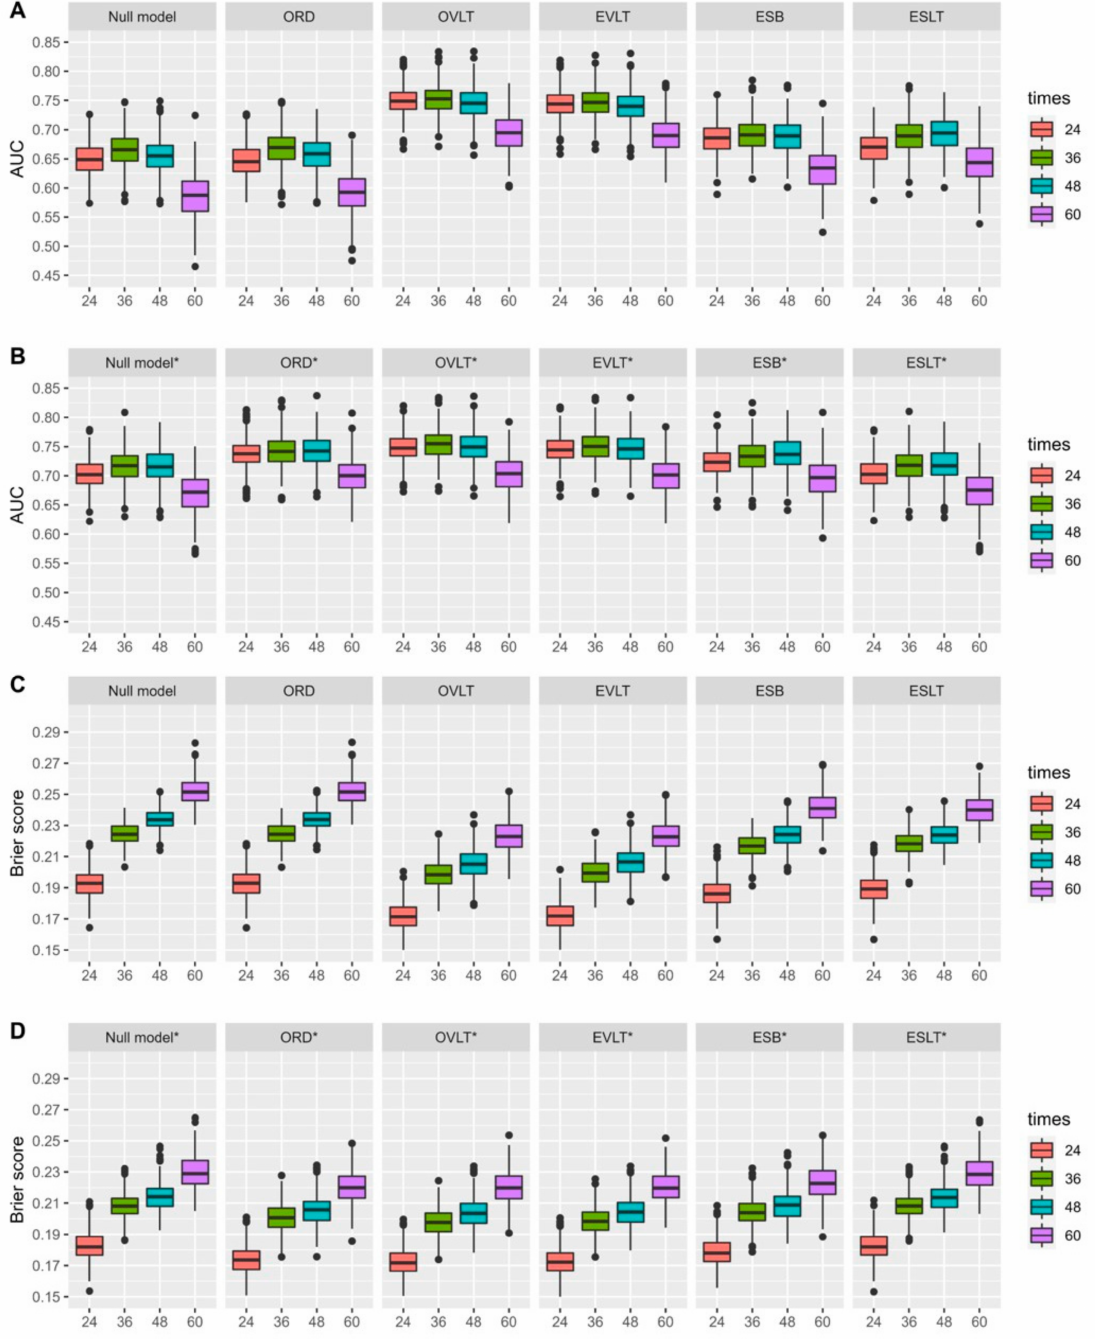
Figure 2. The 10-fold cross-validated AUCs ( A , B ) and Brier scores ( C , D ) for the prediction of overall survival at 24, 36, 48, and 60 months from CA-125 history up to 3 months, considering different CA-125 summaries (ORD, OVLT, EVLT, ESB, ESLT) adjusted ( B , D ) or not ( A , C ) based on the CA-125 value at baseline. Null model: survival model stratified by study, ORD: observed relative decline, OVLT: observed value at landmark time, EVLT: estimated value at landmark time, ESB: estimated slope at baseline, ESLT: estimated slope at landmark time. * models adjusted for CA-125 at baseline. Note: The SCOTROC-1 trial was excluded for the landmark time at 6 months and prediction time at 36 months and for the landmark time at 3 months and prediction time at 48 months. The SCOTROC-4 and MITO-7 trials were excluded for both landmark times and for the prediction time of 60